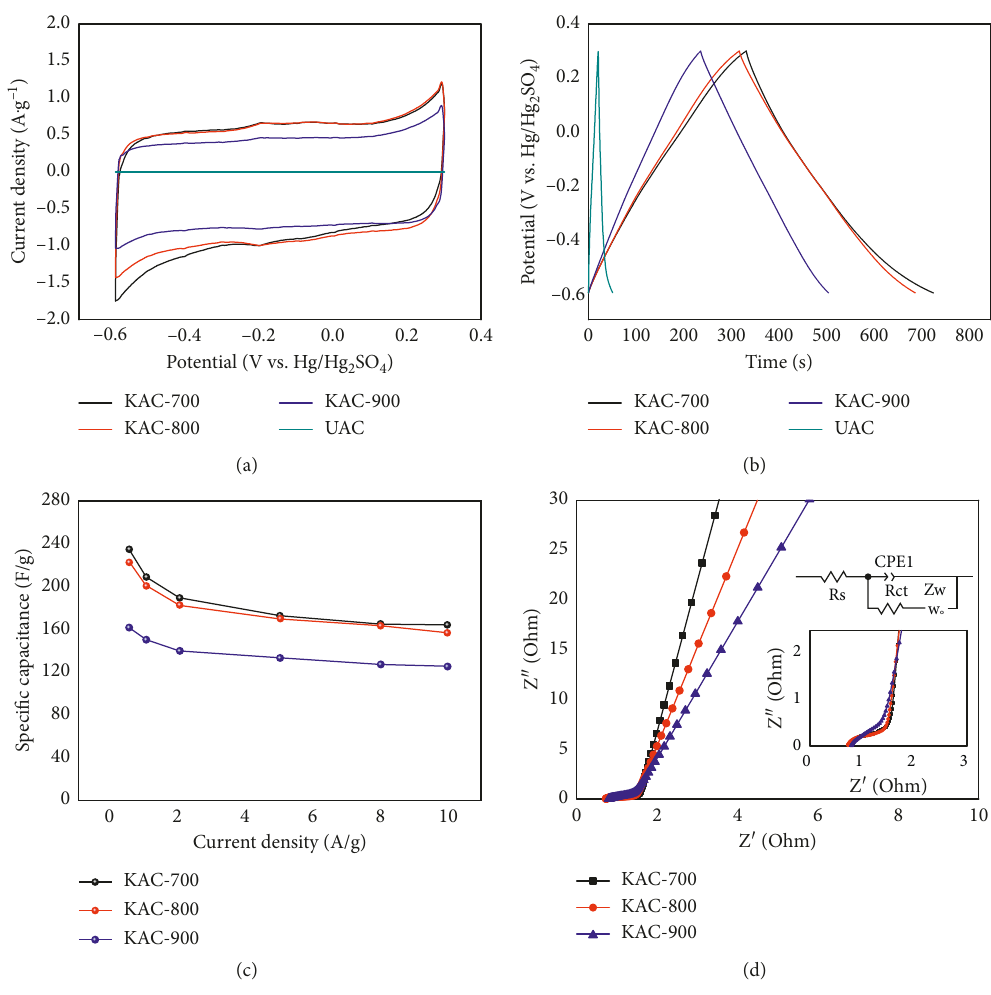
Figure 5: Electrochemical performance of KAC-700, 800, and 900 in 1M H 2 SO 4 aqueous solution. (a) CV curves at the scan rate of 5mV/s, (b) GCD curves at 0.5A/g, (c) specific capacitances under different current densities calculated from GCD data, and (d) Nyquist plots of the achieved samples, the inset images show enlarged impedance at the high frequency and the equivalent